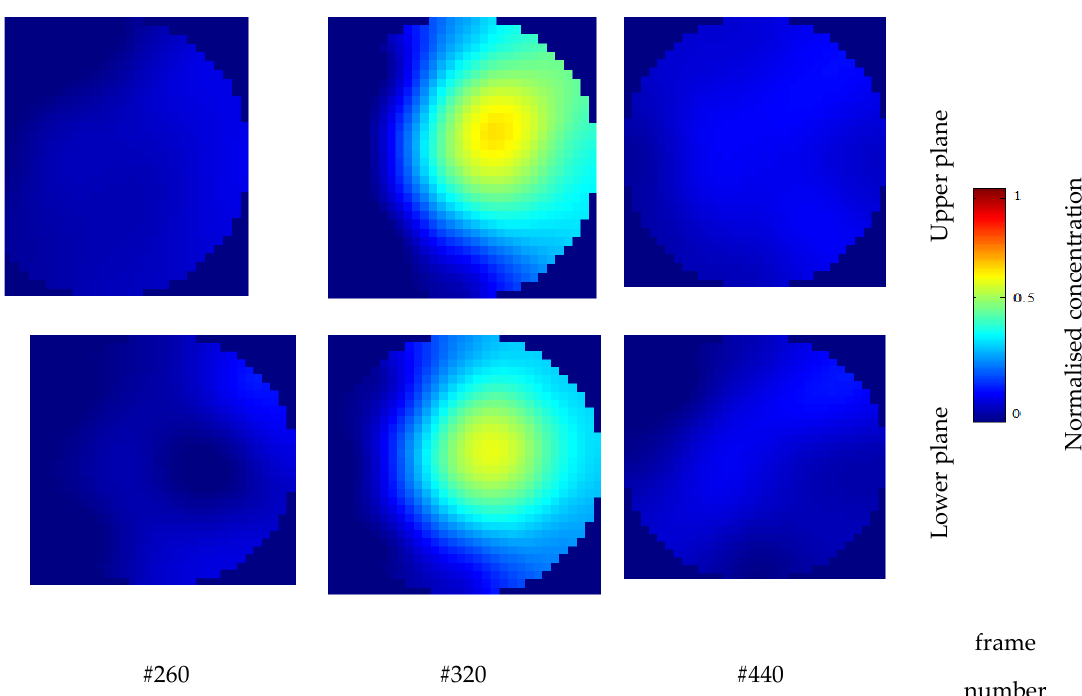
Figure 6. 32 × 32 pixel ECT tomographic images of upper and lower plane for chosen frame number. Figure 7a,b presents the examples of normalized concentration instantaneities in (15,15) pixel during material propagation through the pipe. Figure 7c,d shows the cross-correlation functions of the normalized concentration instantaneities (Figure 7a,b) in chosen pixel position at specified time intervals [#270, #305] and [#303, #345] by the proposed algorithm. The arbitrarily chosen threshold s 0 is 0.1 and the interval of confidence M 0 is 5 frames. The maximum of the correlation function was at shift p = 2 for concentration changes representing in Figure 7a,b, respectively, and calculated particle velocity was 0.01 × 2/0.03 ≈ 0.667m/s.